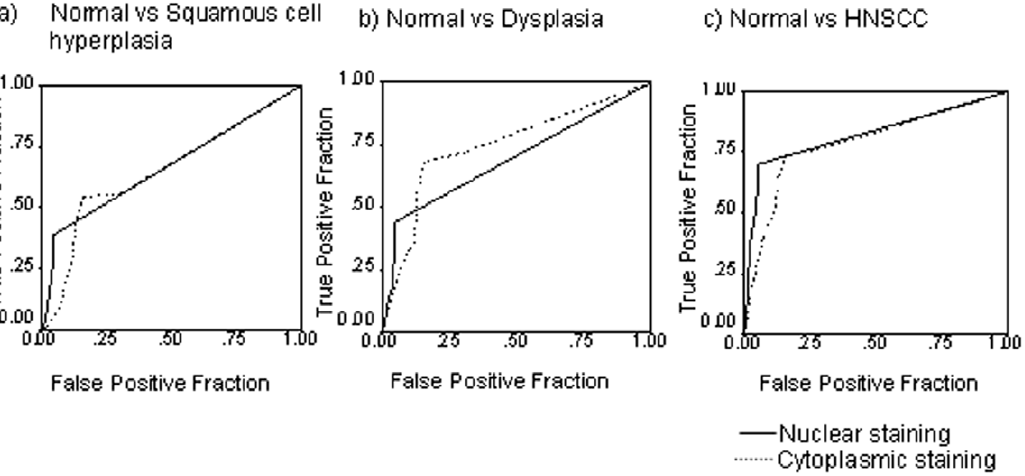
Figure 2. Receiver operating characteristic curves of S100A7 (nuclear/cytoplasmic) in (a) normal vs. squamous cell hyperplasia; (b) normal vs. dysplasia; (c) normal vs. HNSCC. Bold line shows ROC analysis for nuclear S100A7. Dashed line shows ROC analysis for cytoplasmic S100A7. Y-axis of the plot shows true-positive fraction and X-axis shows false positive fraction.